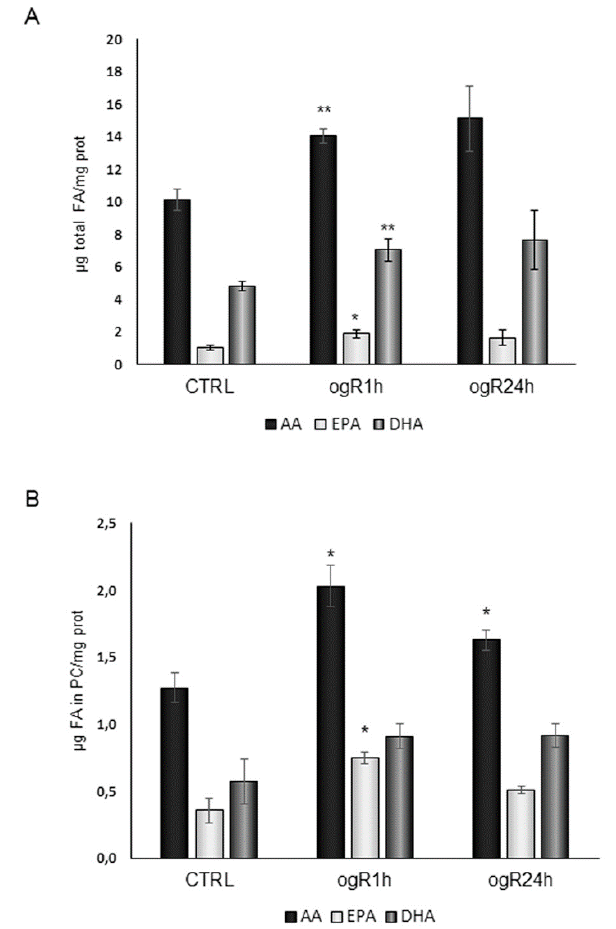
Figure 1. Total polyunsaturated fatty acid (PUFA) content of rat brain endothelial cells (RBE4) cells and of purified phosphatidylcholine (PC) after oxygen and glucose deprivation and restoration (OGD/OgR) treatment for 1 and 24 h. Cells, after OGD/ogR treatment, were collected and lipids were extracted by different mixture of methanol/chloroform. Cell FAs (fatty acids) were measured as FA methyl esters (FAME) by a GC (Agilent Technologies 6850 series II, Santa Clara, CA, US) equipped with flame ionization detector. FAME were quantified using the chromatographic peak area according to the internal standard (IS) method. Histograms represent the most relevant results of whole cell ( A ), and PC ( B ) FA composition. The data are normalized to cellular protein content and expressed as mean ± S.E. from three independent experiments, * p < 0.05, ** p < 0.01 vs. control.